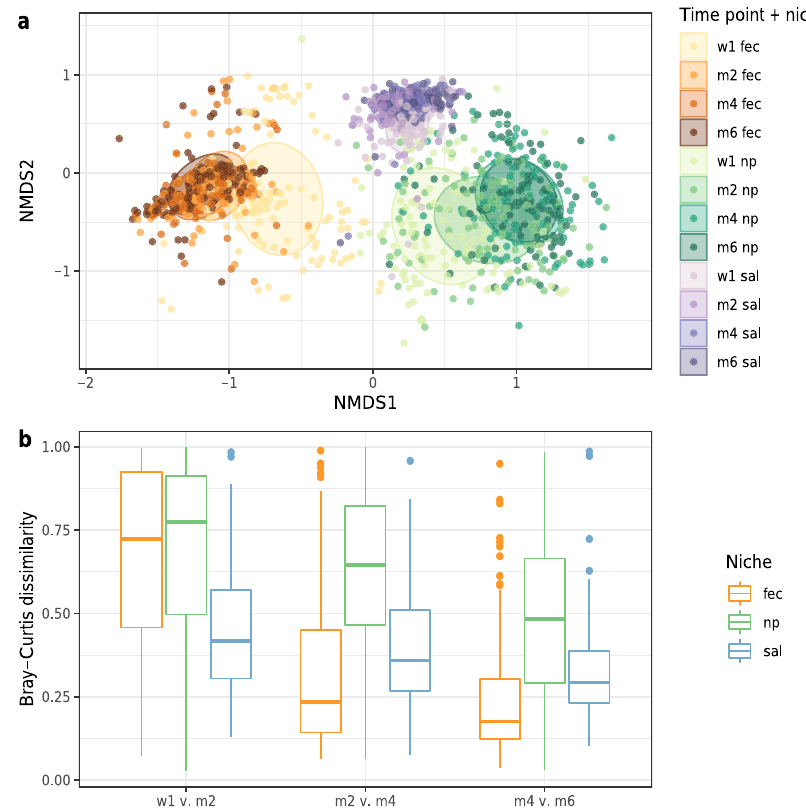
Fig. 1 Development of the microbiota community composition for individual niches over time. Non-metric multidimensional scaling (nMDS) plot ( a ), based on Bray – Curtis (BC) dissimilarity between samples, visualising the overall gut microbial community composition strati fi ed for each niche per time point. Each data point represents the microbial community composition of one sample. The ellipses represent the standard deviation of data points belonging to each group, with the centre points of the ellipses calculated using the mean of the coordinates per group. The stress of the ordination was 0.18. In panel b the temporal community stability for each niche is shown. As a measure of microbiota stability, we calculated the Bray – Curtis distance between consecutive sample pairs belonging to each individual per time interval, i.e., between week 1 and month 2, between month 2 and month 4, and between month 4 and month 6. Boxplots with medians are shown; the lower and upper hinges correspond to the fi rst and third quartiles (the 25th and 75th percentiles); the upper and lower whiskers extend from the hinge to the largest and smallest value no further than 1.5*IQR from the hinge; outliers are plotted individually. Fec faeces, np nasopharynx, sal saliva. Temporal stability was highest for the saliva samples in early-life, which was later overtaken by a higher stability in consecutive faecal samples (median BC dissimilarity between months 4 and 6 for faecal samples 0.18 versus 0.29 for saliva, Wilcoxon test, p <